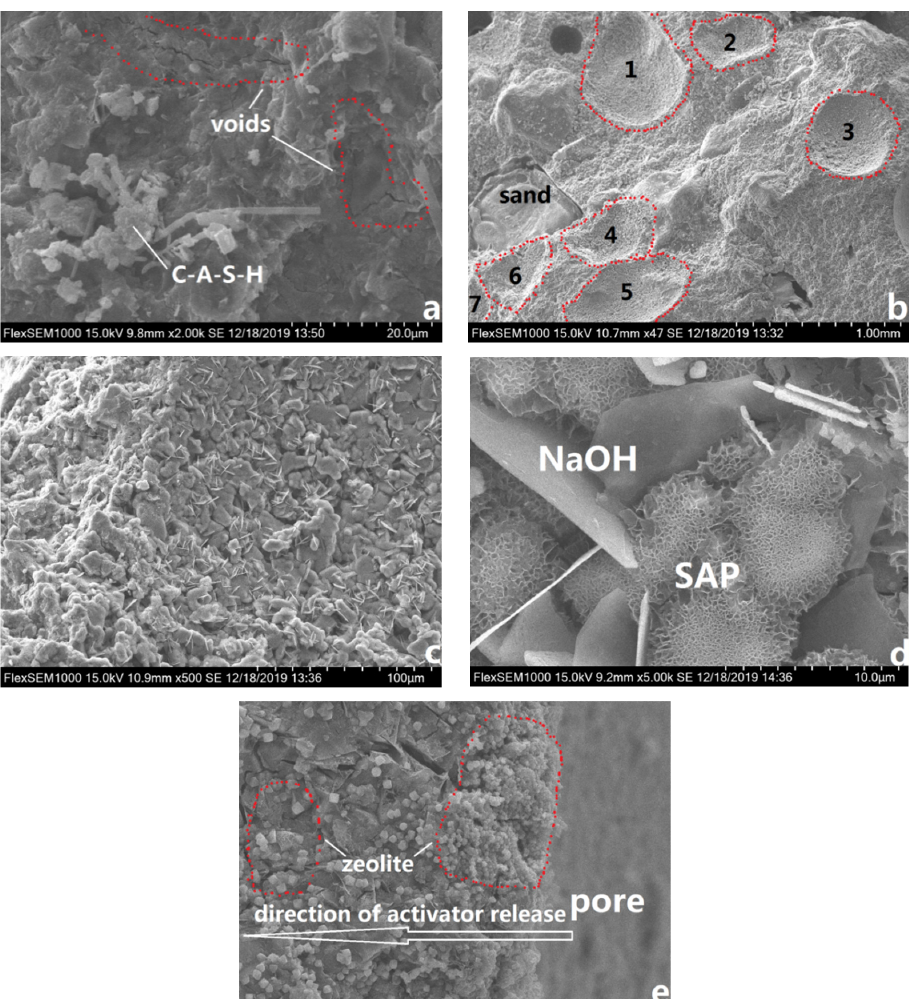
Figure 6. SEM images of AAS mortars: ( a ) S0 and ( b – e ) S20 .